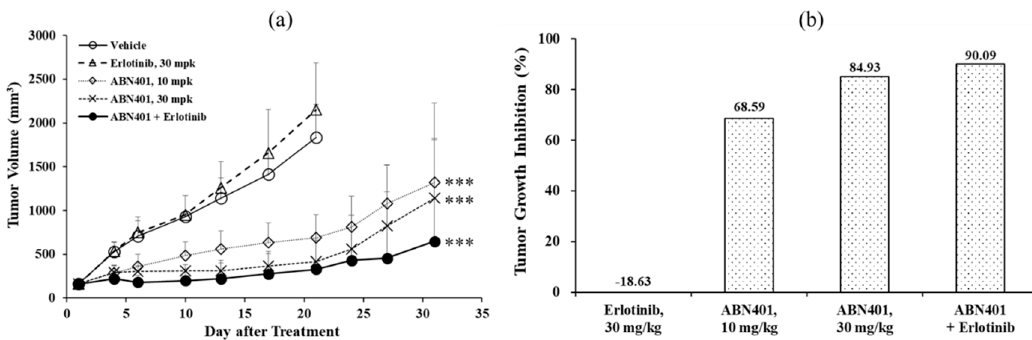
Figure 6. In vivo therapeutic efficacy of ABN401 in NSCLC patient-derived xenograft (PDX) models. ( a ) Growth curves of LU0858 NSCLC tumors in ABN401 and / or erlotinib-treated mice. Dose-dependent anti-tumor activity of ABN401 and in vivo anti-tumor activity of erlotinib alone or in combination with ABN401 is shown. P -values: *** < 0.001. ( b ) Tumor growth inhibition values on day 21 are shown.